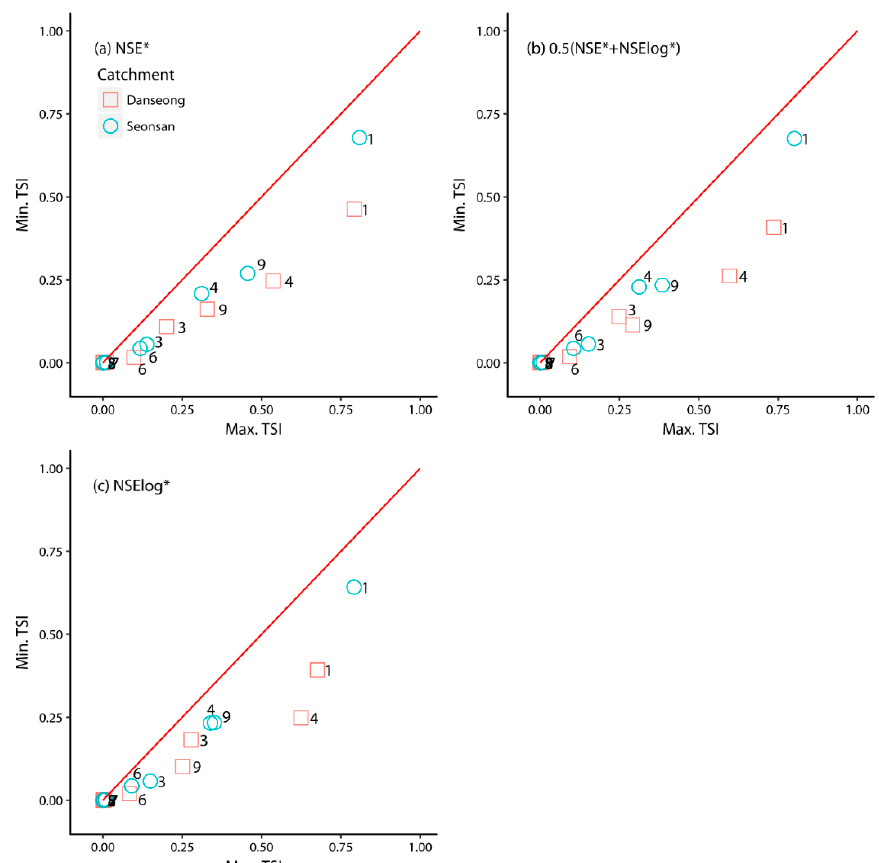
Figure 8. Differences in parameter sensitivity of Danseong and Seonsan catchments, calculated for the three objective functions. Numbers in symbols indicate parameter numbers in Table 2. ( a ) NSE*; ( b ) 0.5(NSE* + NSElog*); ( c )